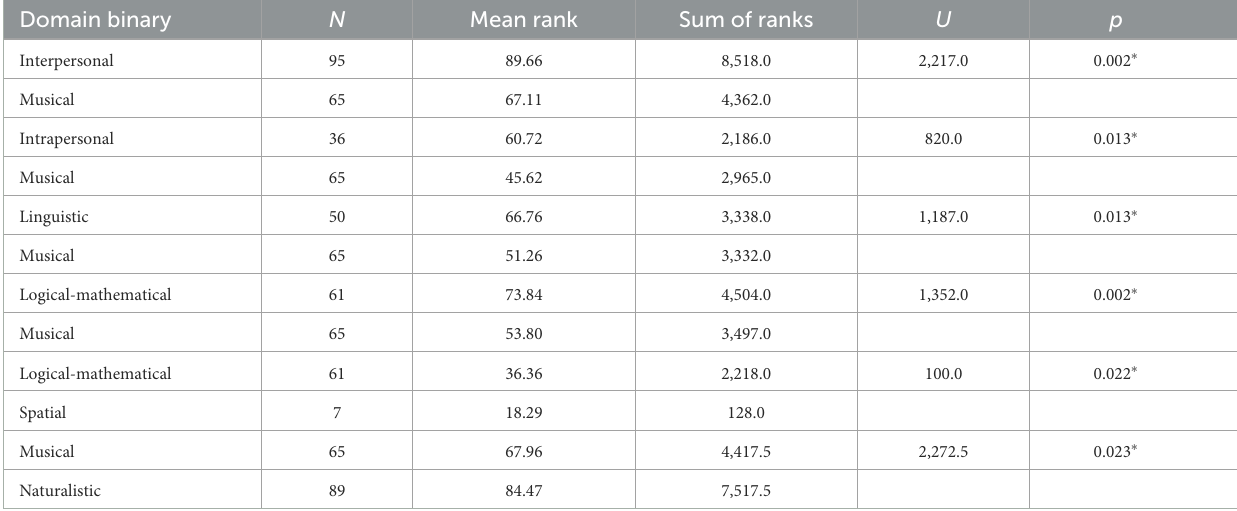
TABLE 8 Pairwise comparisons of the twenty-first-century skills scale scores of university students obtained from the twenty-first-century skills scale by the self perceived intelligence types. Domain binary N Mean rank Sum of